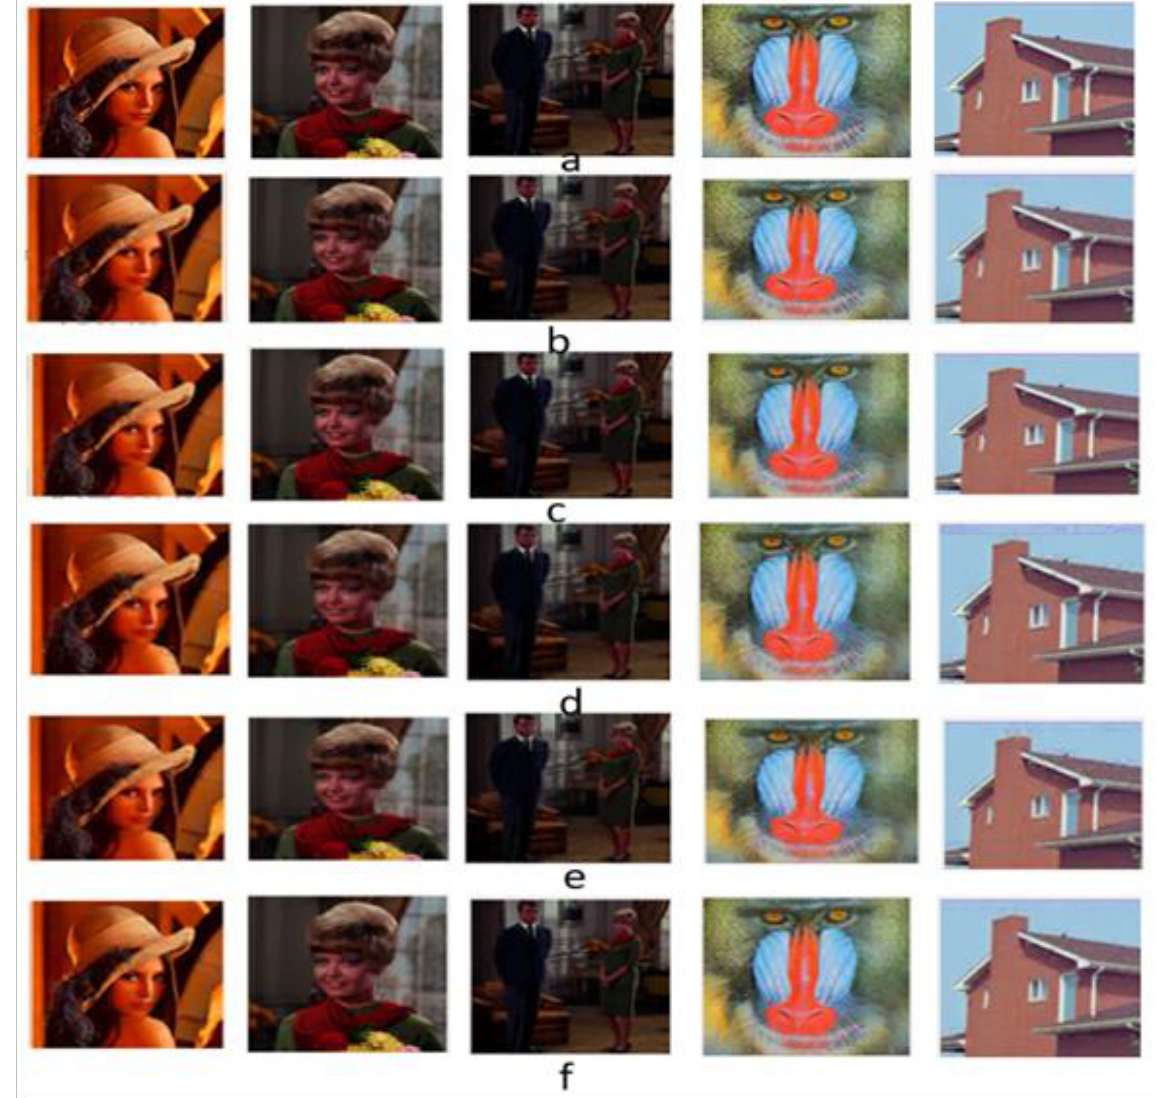
Figure 4. Reconstructed Lena, Zelda, Couple, Baboon and House image by using different ABCS methods ( a ) original image, ( b ) BCS-SPL, ( c ) STD-BCS-SPL, ( d ) ENT-ABCS, ( e ) EABCS, ( f ) FABC at 0.5 sampling rate.